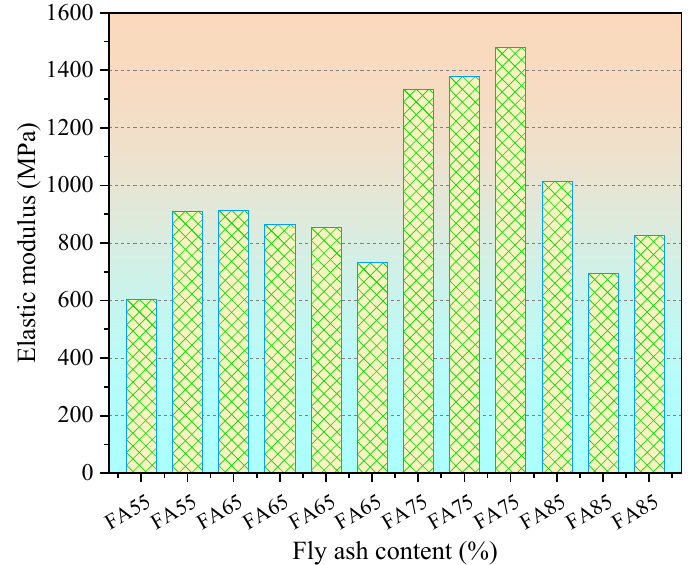
Figure 6. The elastic modulus of CMFB with a curing time of 56 d.